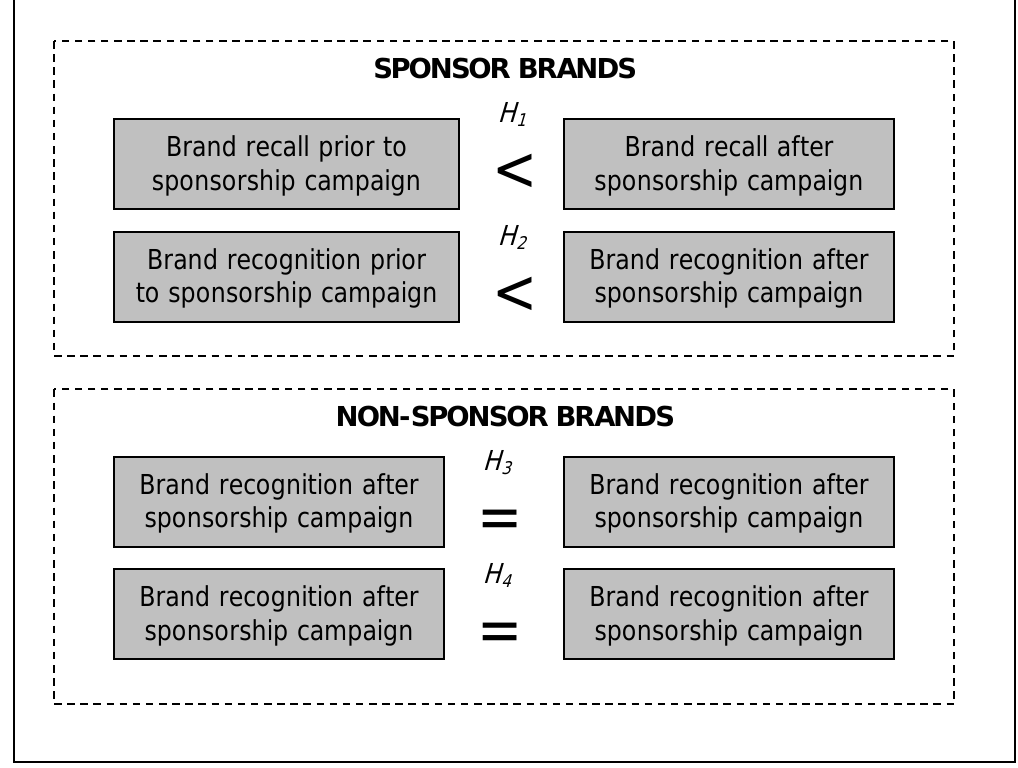
Figure 1: Summary of